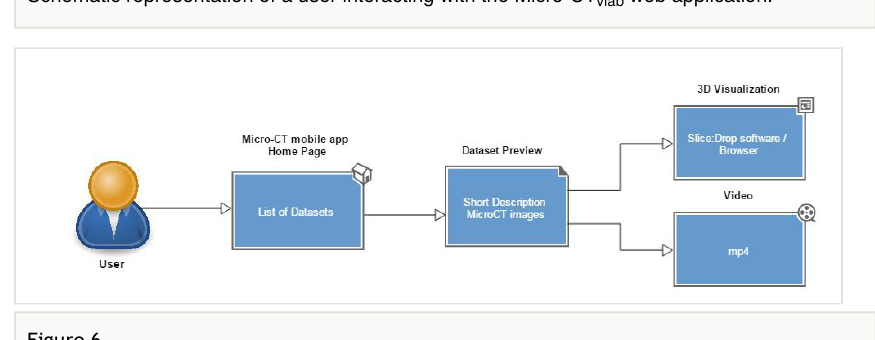
Figure 5. Schematic representation of a user interacting with the Micro-CT web application. vlab